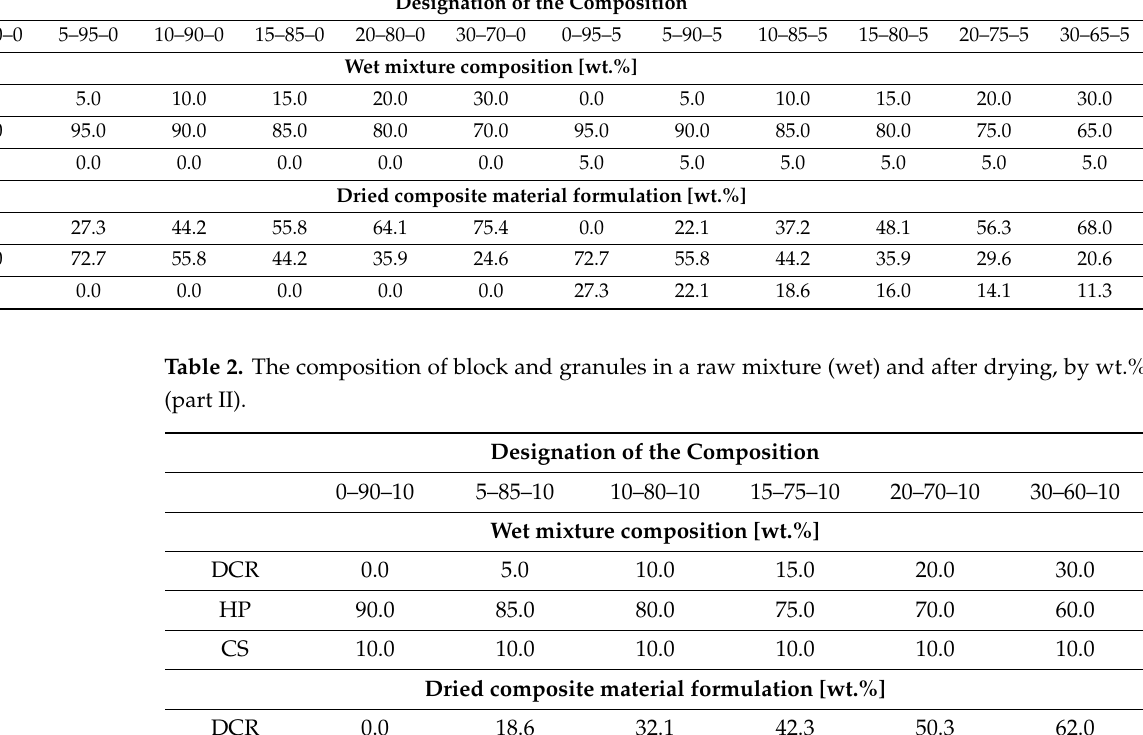
Table 1. The composition of block and granules in a raw mixture (wet) and after drying, by wt.% (part I). Designation of the Composition